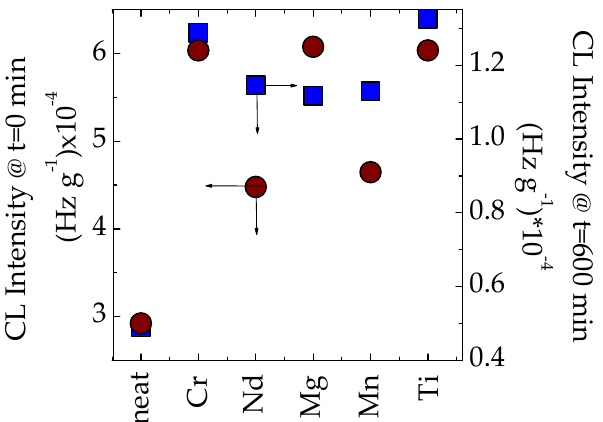
Figure 3. The isothermal CL spectra recorded on the pristine PCL-based samples containing PbZrO 3 doped with various metallic atoms. Testing temperature: 140 °C.